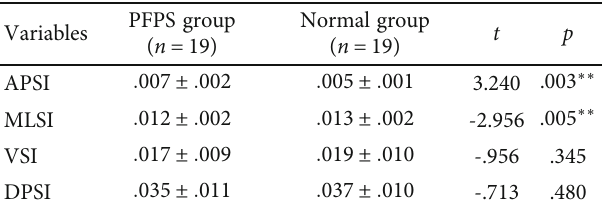
Table 3: Results of dynamic stability